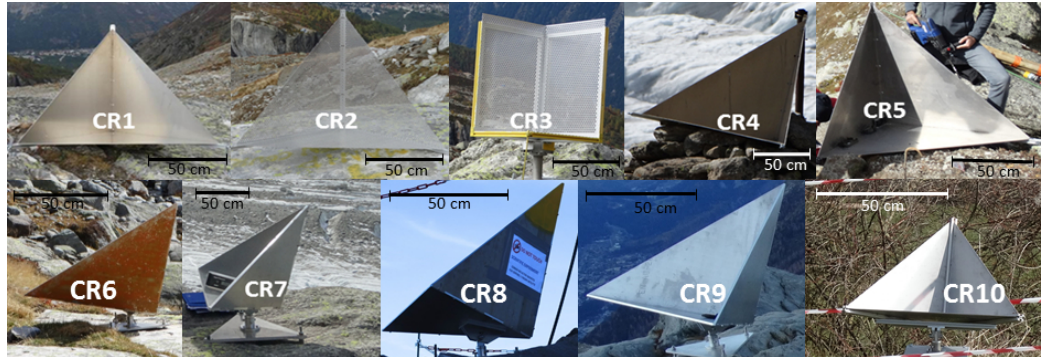
Figure 1. Illustration of nine triangular trihedral Corner Reflectors (CRs) and one rectangular trihedral CR (CR3) used in the experimentations.